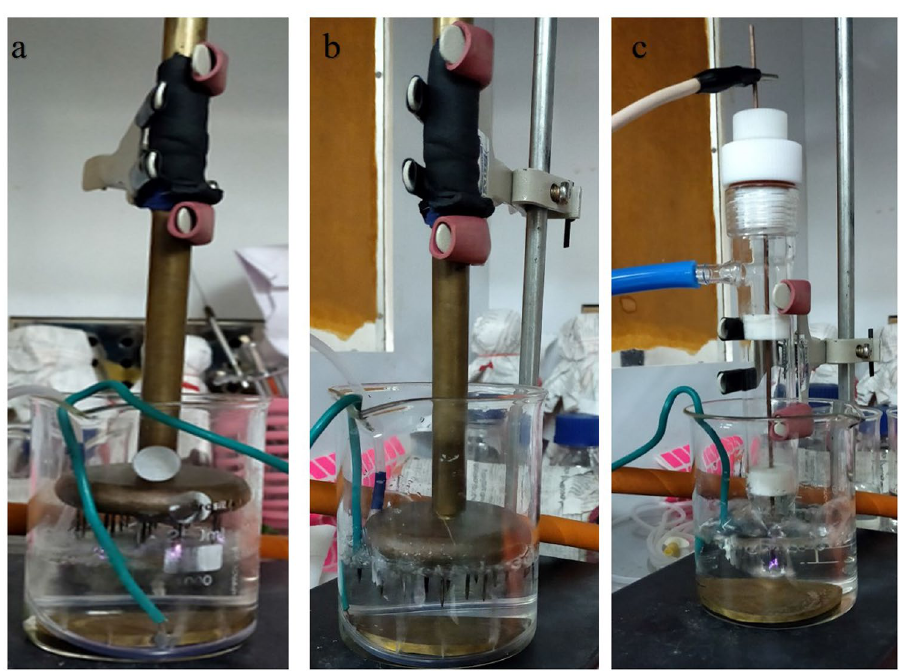
Figure 4. Dynamic water treatment with multiple pin HV electrode to plane ground electrode by arranging HV electrode in ( a ) α -configuration and ( b ) β -configuration and with ( c ) immersed